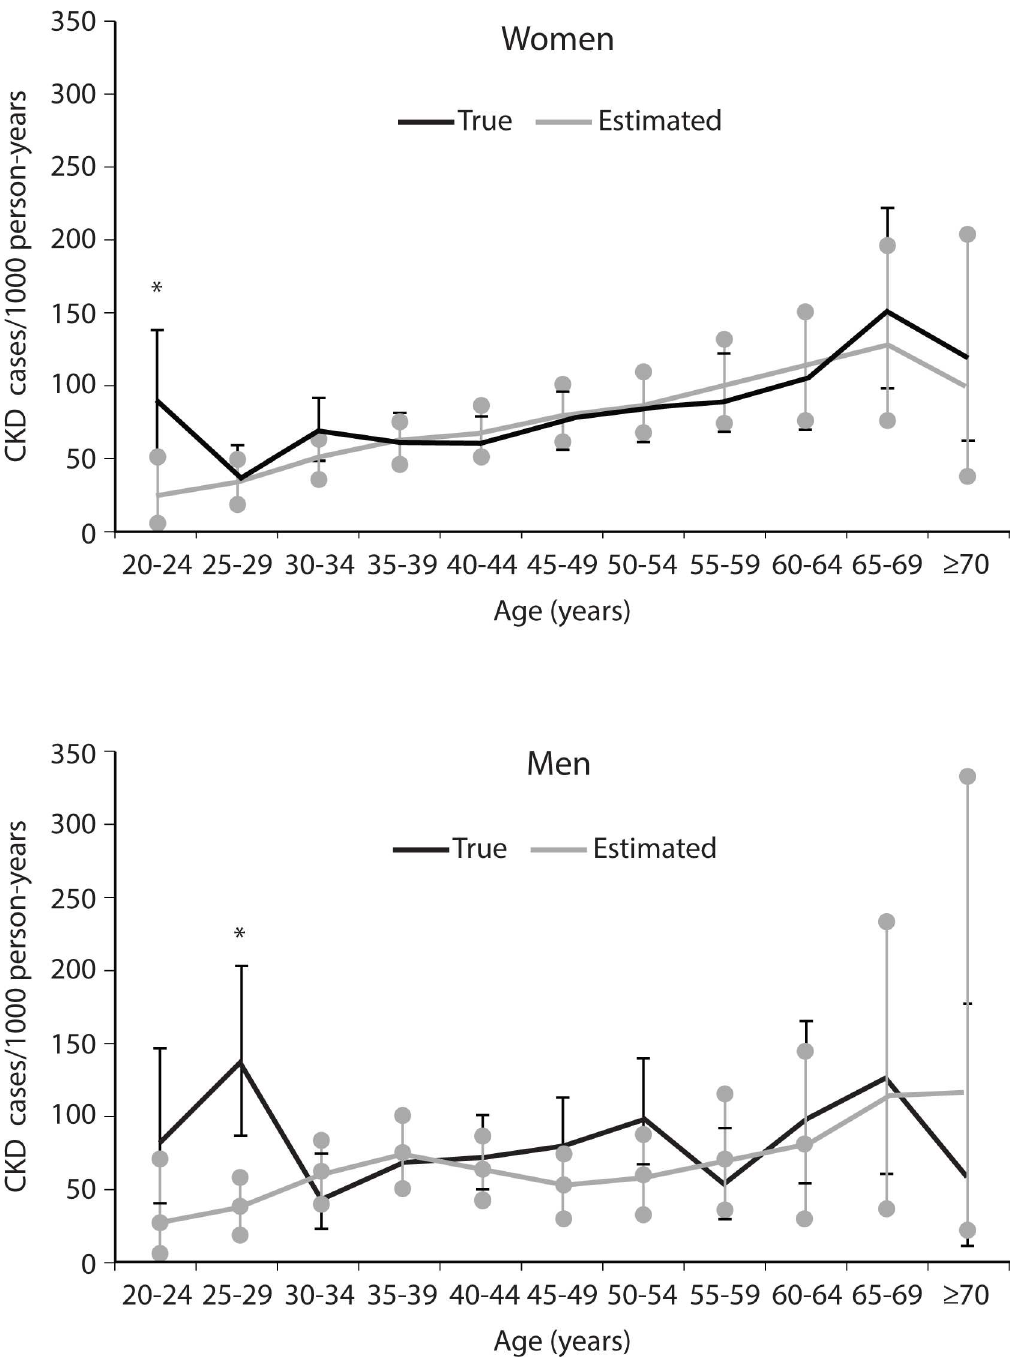
Fig 2. Age- stratified observed and estimated incidence rates of CKD in women (above) and men (below) during the period 1982–2007. The asterisk ( * ) indicatessignificantdifference betweentrue and estimated CKD